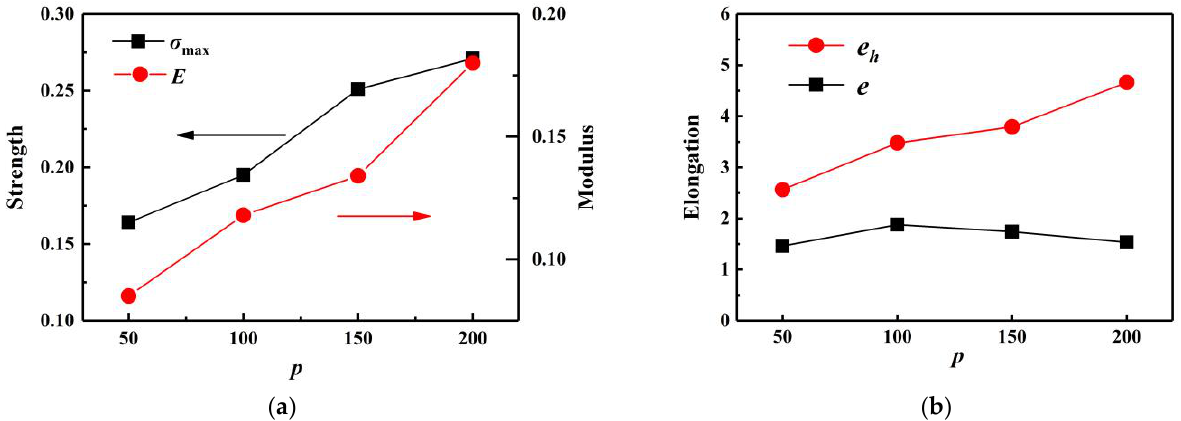
Figure 5. Mechanical property parameters as a function of p : ( a ) maximum strength and elasticity modulus; ( b ) elongation at σ max and at break.